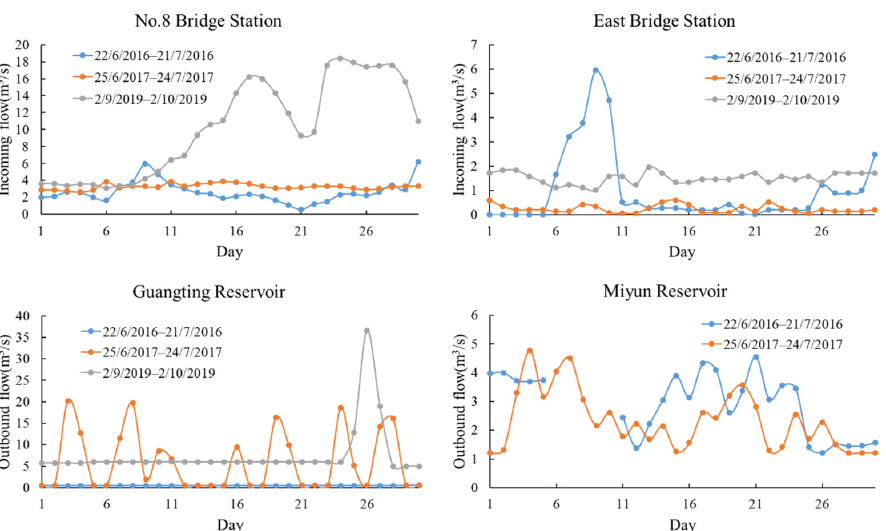
Figure 7. Inflow and outflow of the Guanting Reservoir (number 8 bridge measuring point and east bridge measuring point) 30 days before and after the retrieval date. Compared with Miyun Reservoir in the same period in 2016 and 2017, the annual change of the outbound flow of Guanting reservoir is larger.